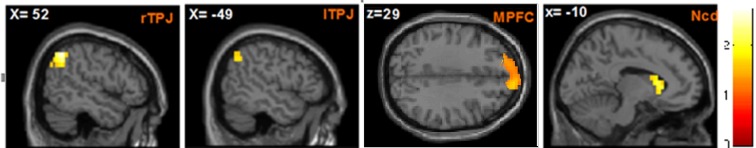
FMRI results: Parochial altruism.When player C observes unfair behavior in the in-in group condition (IN-IN) the recruitment of the mentalizing system, the medial prefrontal cortex (MPFC), and the right and left temporal-parietal junction (rTPJ and lTPJ) and, in addition, of the caudate nucleus (CN) were observed.